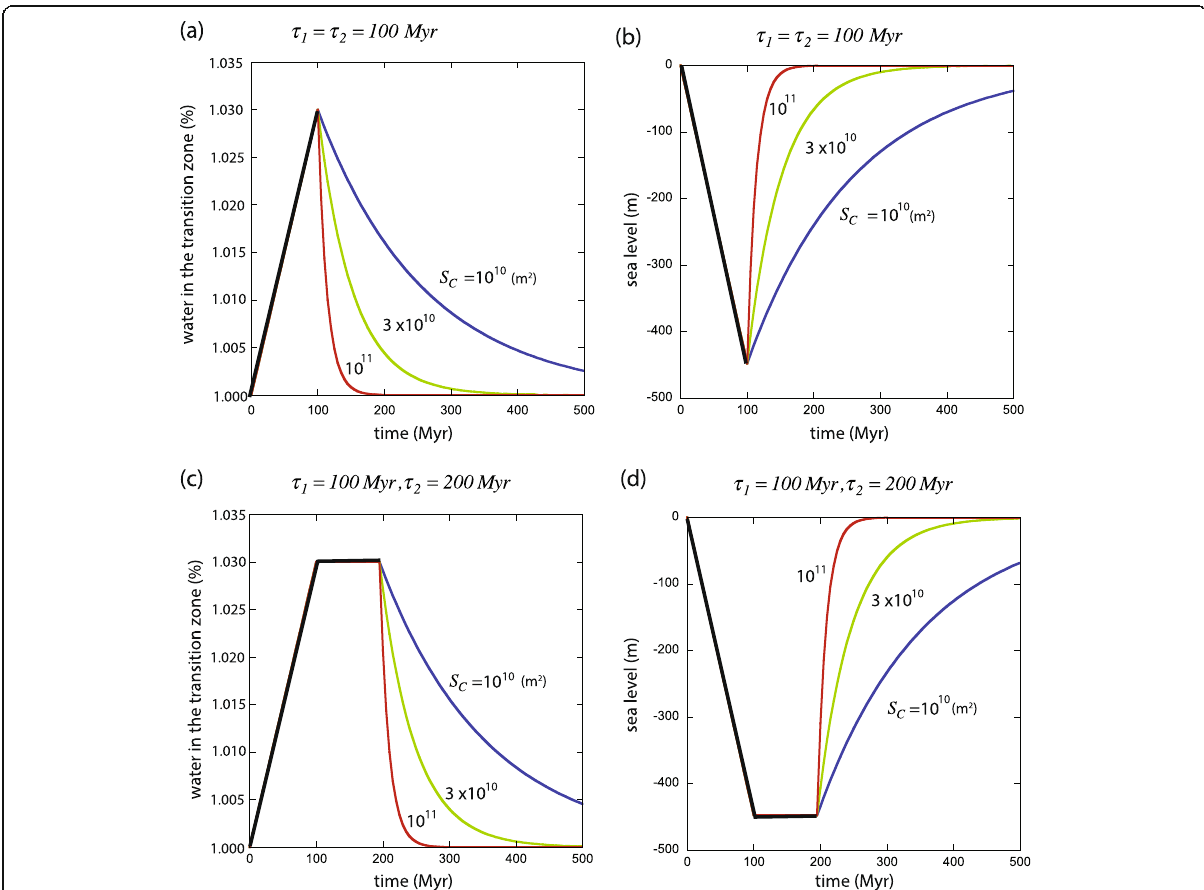
Fig. 13 Results of model calculations on ocean mass history. Regassing parameters (rate of regassing and duration of regassing pulse ( τ 1 )) are chosen to reproduce the inferred rapid sea-level drop (2 – 3 m/Myrs (in the last ~ 100 Myrs); Fig. 6). Degassing parameters include the area of cool regions with excess degassing ( S C ) and the delay time ( τ 2 ) for degassing since the beginning of excess regassing (and the plume upwelling velocity (~ 1 m/year)). a H istory of the water content in the MTZ ( τ 1 = τ 2 =100 Myrs). b S ea-level change corresponding to the model shown in ( a ) using a relation Δ z ≈ − z M MTZ Δ X MTZ ( Δ z : sea-level change, z : average depth of the oceans (= 3730 m), M MTZ : mass of the MTZ (= 4 × 10 23 kg)), W ocean τ Δ X 21 kg)). b Same as ( a ) except that τ MTZ : change in the water content of the MTZ; W ocean : mass of oceans (=1.4 × 10 1 =100 Myrs, and 2 =200 Myrs. c Same as ( b ) except that τ 1 =100 Myrs, and τ 2 =200 Myrs. Observed sea-level changes (Fig. 7) can be explained with S C =(3 – 10) × 10 10 (m 2 ) (i.e., a region with 200 – 350 km